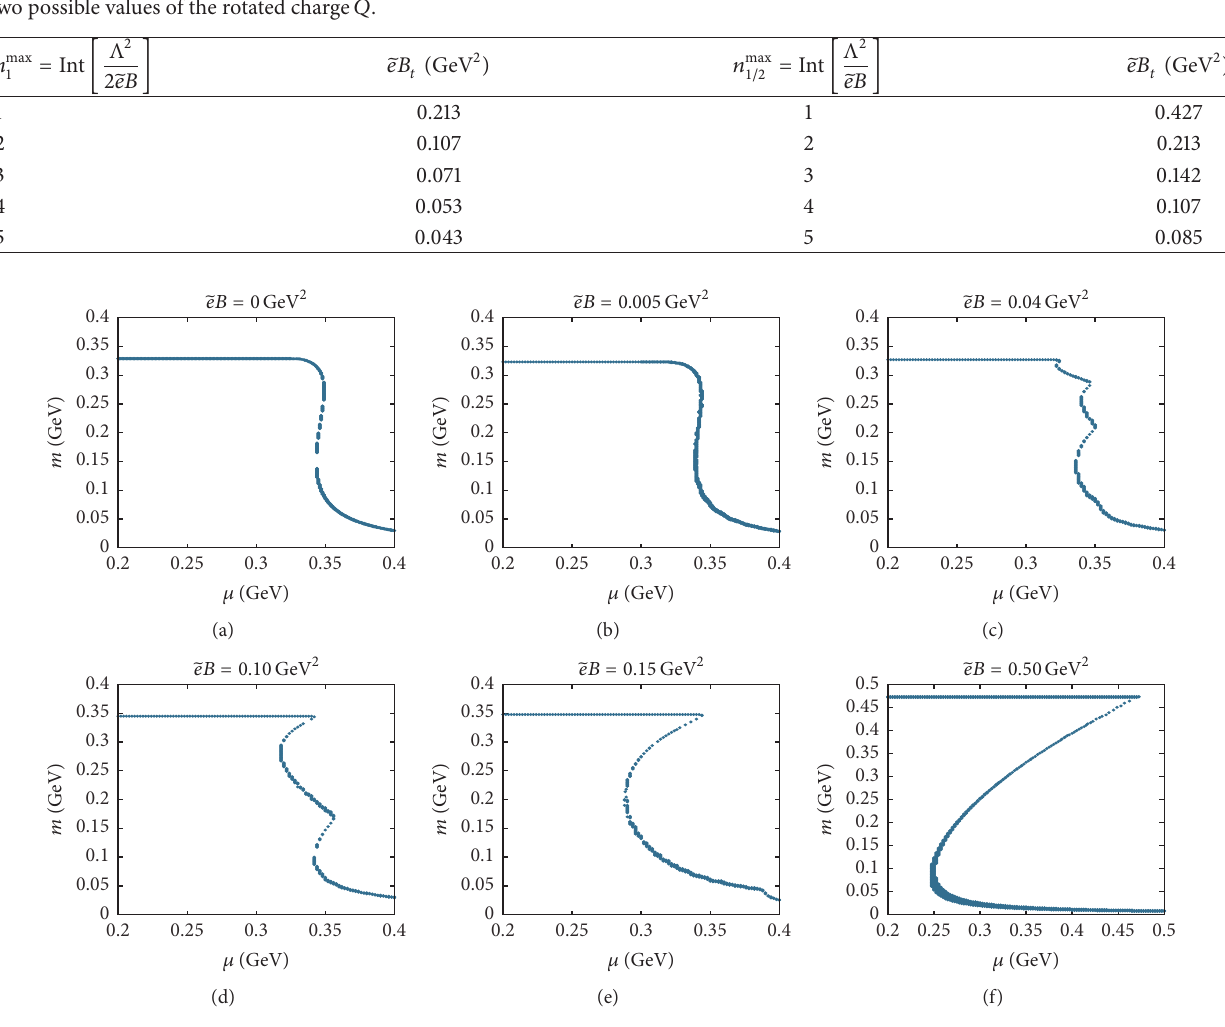
Figure 1: Chiral gap 𝑚 as functions of 𝜇 for 𝜌 = 𝐺 𝐷 /𝐺 𝑆 = 0 with increasing magnetic field ̃𝑒𝐵 at 𝑇 = 0 .